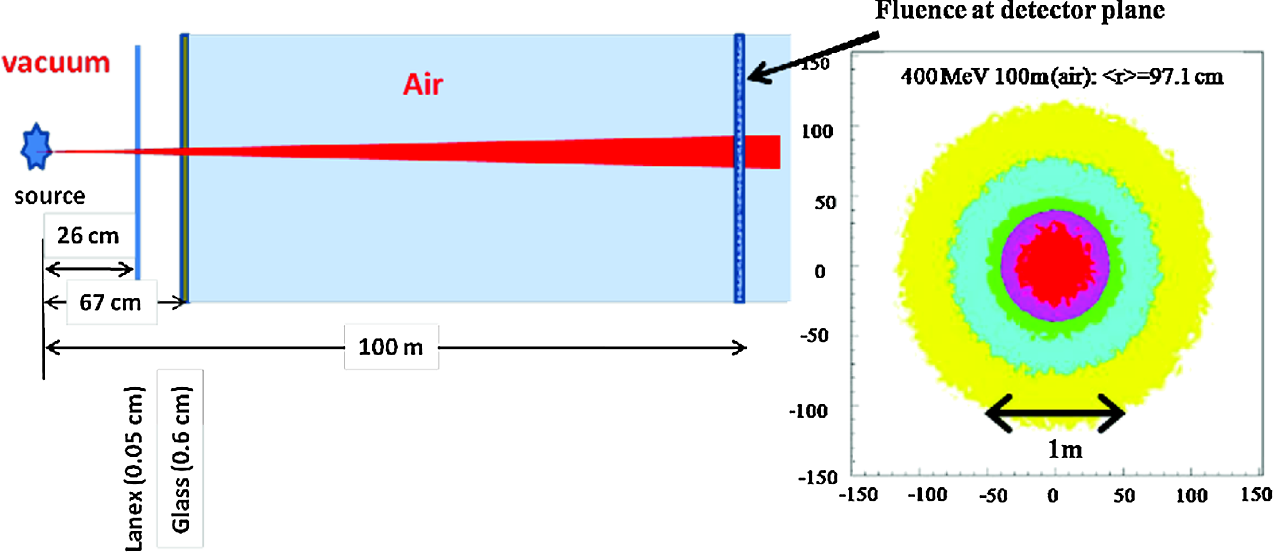
FIG. 5. A Monte Carlo simulation of a point source electron beam of energy 400 MeV with a cone angle of 8 mrad, exiting the vacuum chamber to reach a tally plane 100 m from the source. The electron beam spreads to a diameter of about a meter at this distance whereas the unscattered beam would measure 0.8 m in diameter, at the same distance from the